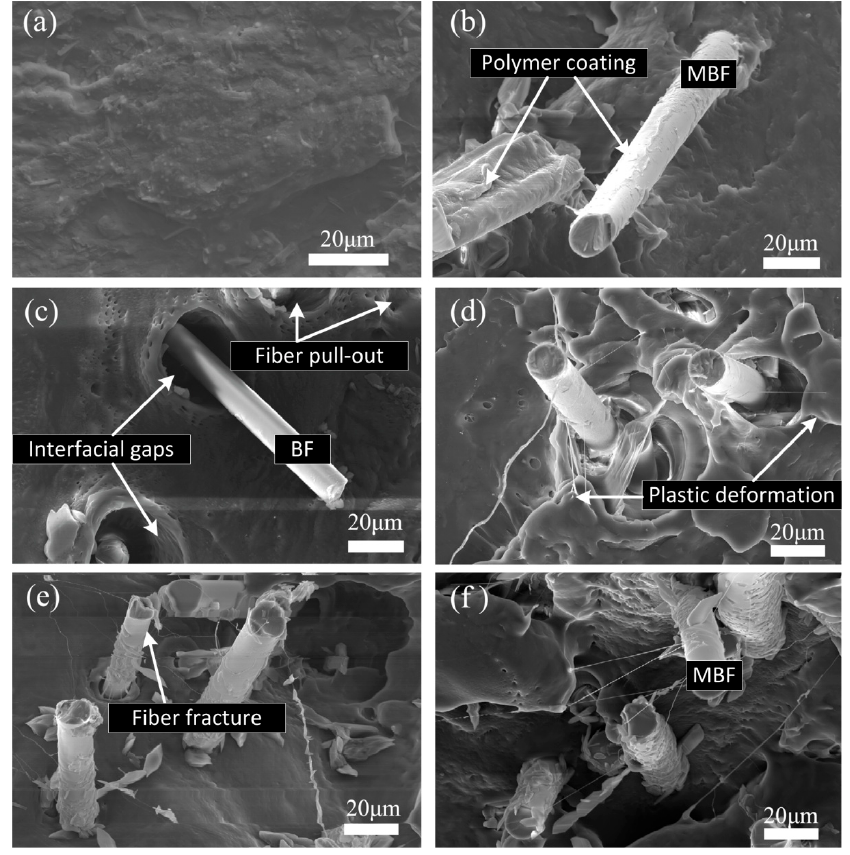
Figure 9. Scanning electron microscopy (SEM) micrographs of tensile fractured surfaces of ( a ) PBS, ( b ) PBS/MBF (98/2), ( c ) PBS/BF (95/5), ( d ) PBS/MBF (95/5), ( e ) PBS/MBF (90/10), and ( f ) PBS/MBF (85/15).